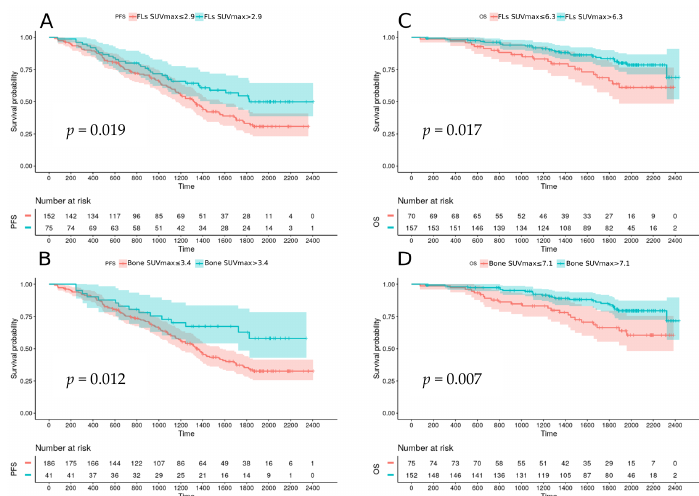
Figure 2. Progression free survival according to FL SUVmax ( A ) and Bone SUVmax ( B ) at baseline; Overall survival according to FL SUVmax ( C ) and bone SUVmax ( D ) at baseline. A baseline BM SUVmax higher than 5.9 also negatively affects OS ( p = 0.013) (Figure 3).